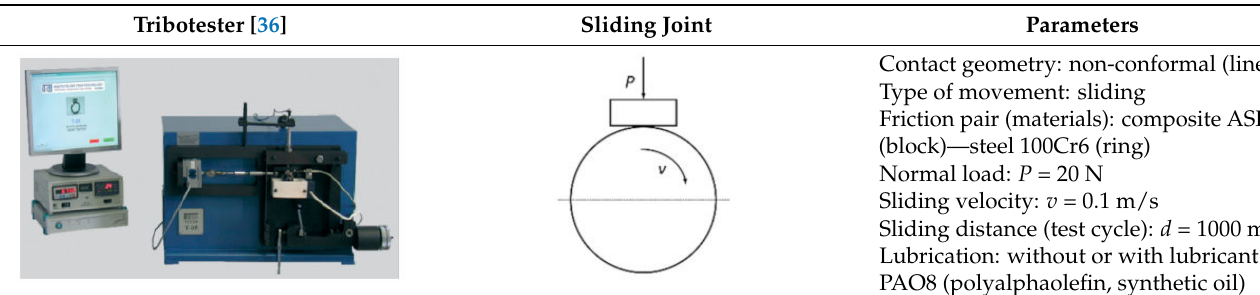
Table 2. Characteristic of tribological